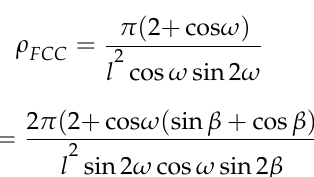
Table 2. Mechanical properties of PR48.